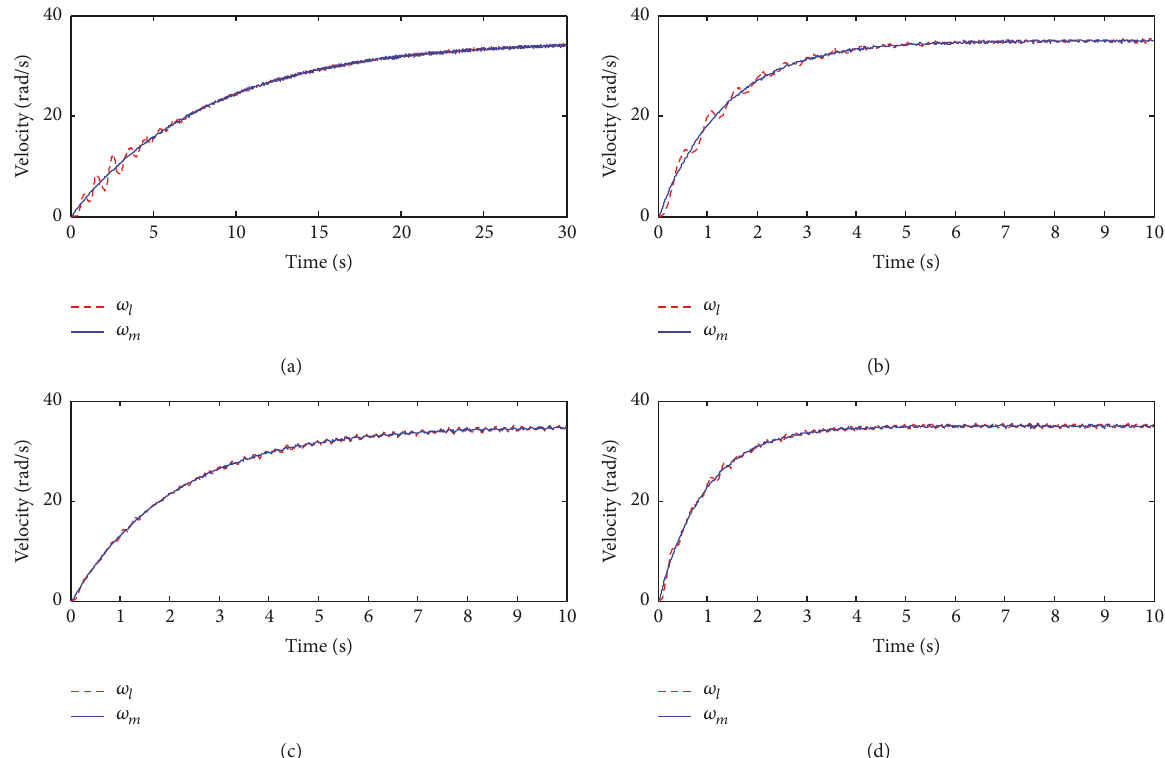
Figure 9: The experimental velocity responses of load side with different springs (𝑞 = 0.285) : (a) spring 1, 𝐾 𝑝 = 0.0175, 𝐾 𝑖 = 1.5771 ; (b) spring 2, 𝐾 𝑝 = 0.0276, 𝐾 𝑖 = 3.9537 ; (c) spring 3, 𝐾 𝑝 =0.032, 𝐾 𝑖 =5.3; (d) spring 4, 𝐾 𝑝 = 0.0393, 𝐾 𝑖 = 7.984